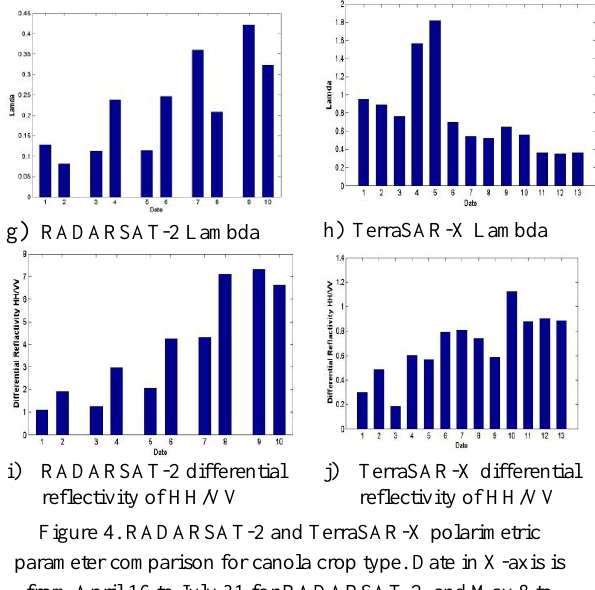
Figure 4. RADARSAT-2 and TerraSAR-X polarimetric parameter comparison for canola crop type. Date in X-axis is from April 16 to July 31 for RADARSAT-2, and May 8 to September 17 for TerraSAR-X as shown in Table 1 The X-axis in all figures refers to the date index in Table 1 of RADARSAT-2 and TerraSAR-X data. The RADARSAT-2 date index 3-10 and